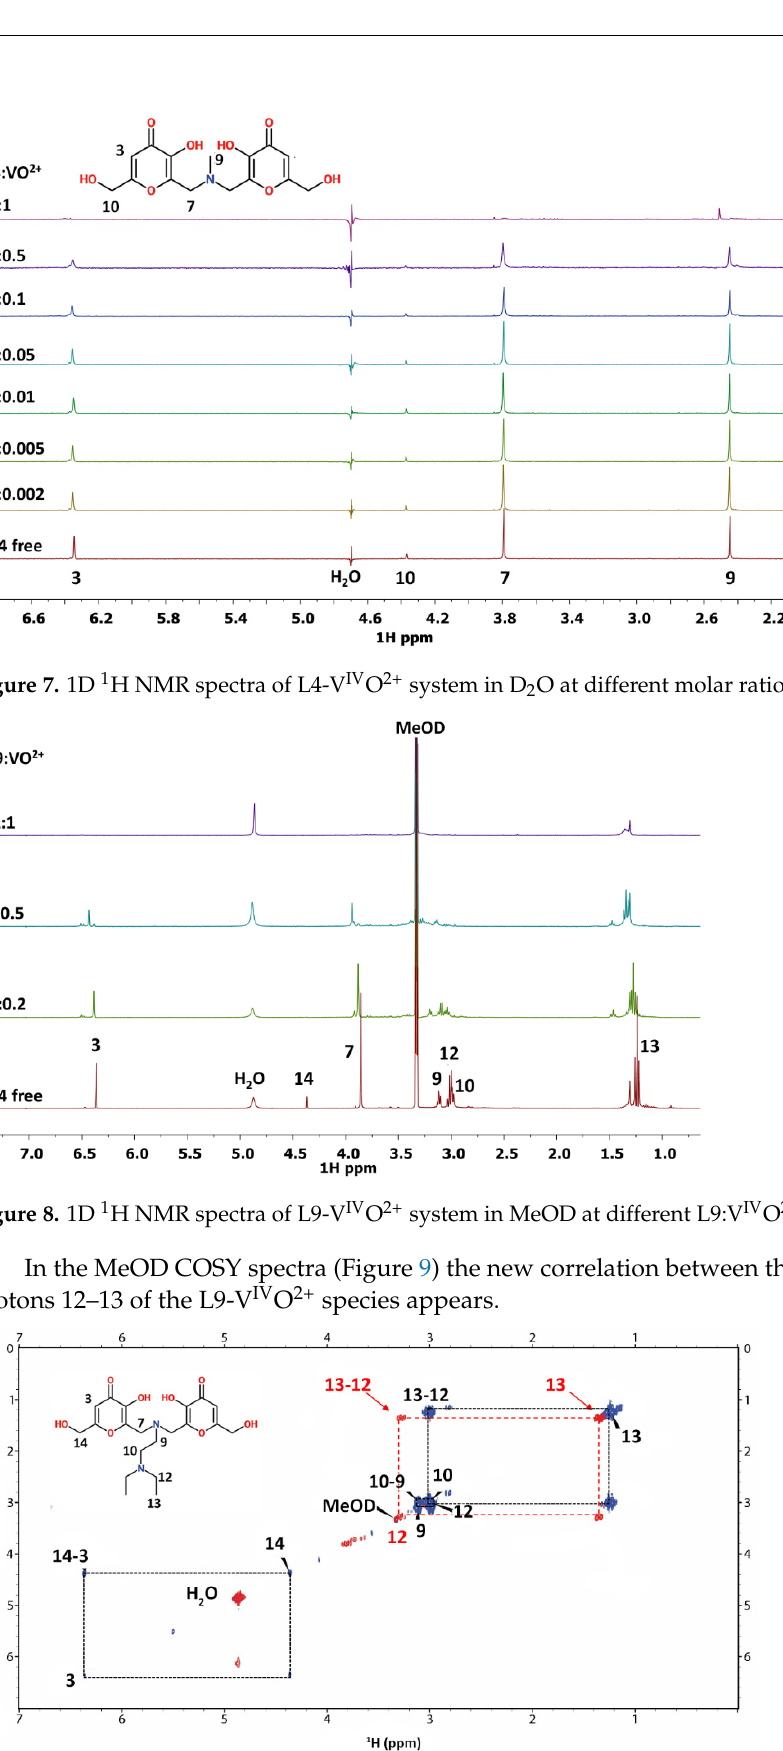
Figure 9. Comparison of 2D 1 H- 1 H NMR COSY spectra of L9 free (blue) and L9-V IV O 2+ (red) systems in MeOD solution.